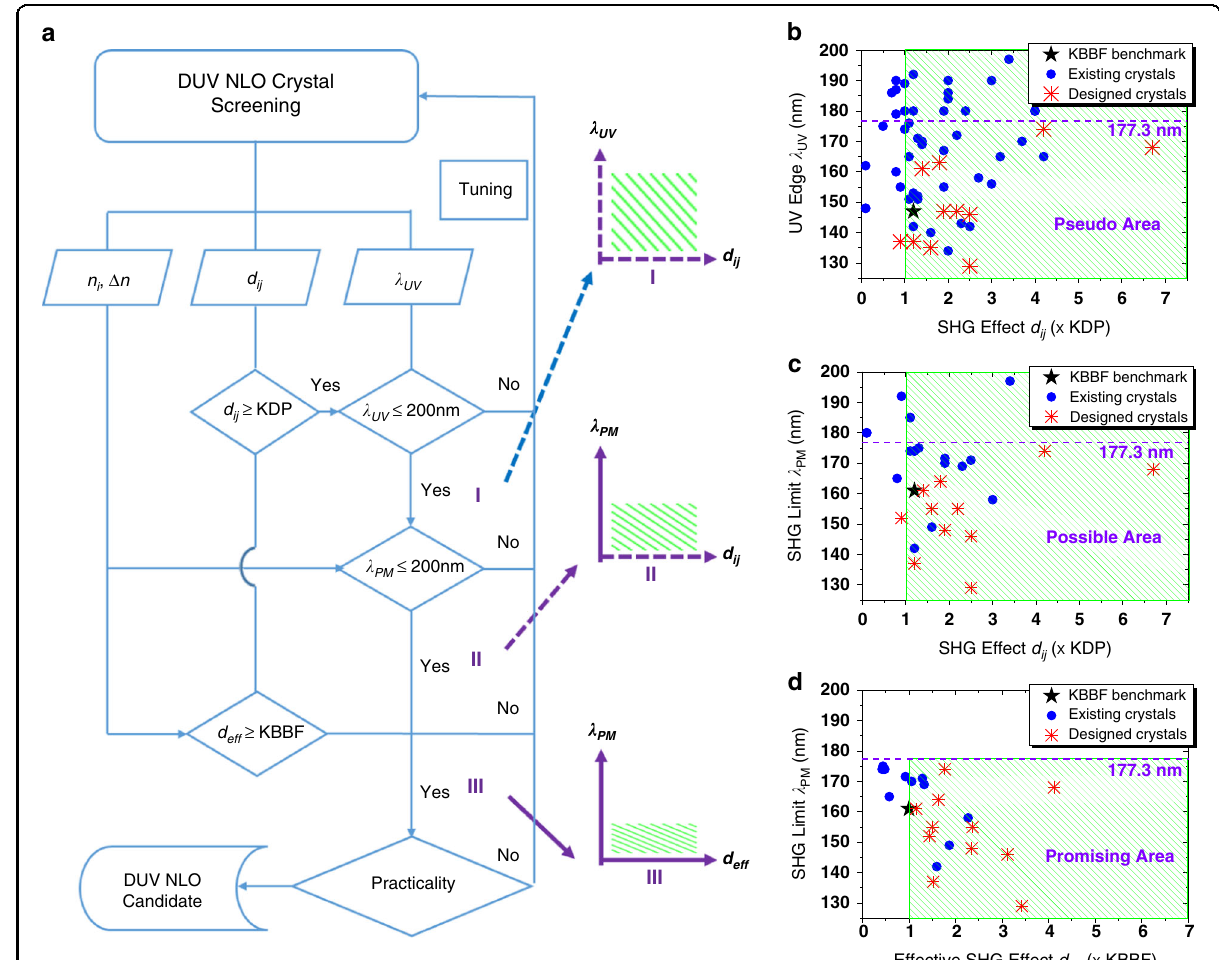
Fig. 1 Key performance criteria of DUV NLO crystals and related materials. Screening scheme of DUV NLO crystal candidates ( a ), key criteria coordinates (I, II, III), and corresponding structures of “ pseudo ” ( b ), “ possible ” ( c ), and “ promising ” ( d ) DUV NLO